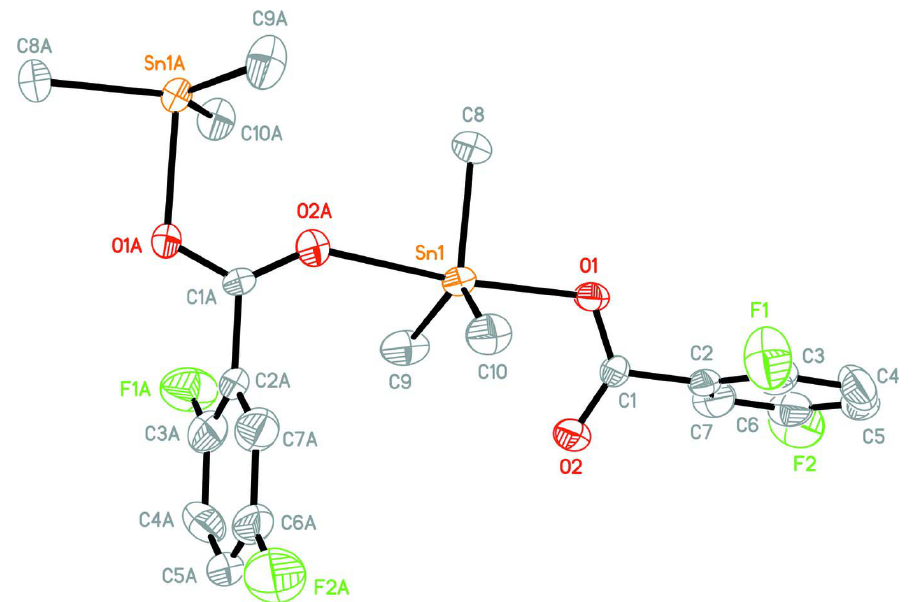
The molecular structure of the compound, showing 50% probability displacement ellipsoids. H atoms have been omitted for clarity. Symmetry codes: (A) = x - 1/2,- y + 3/2,- z + 1/4, (B) = x + 1/2,- y + 3/2,- z +